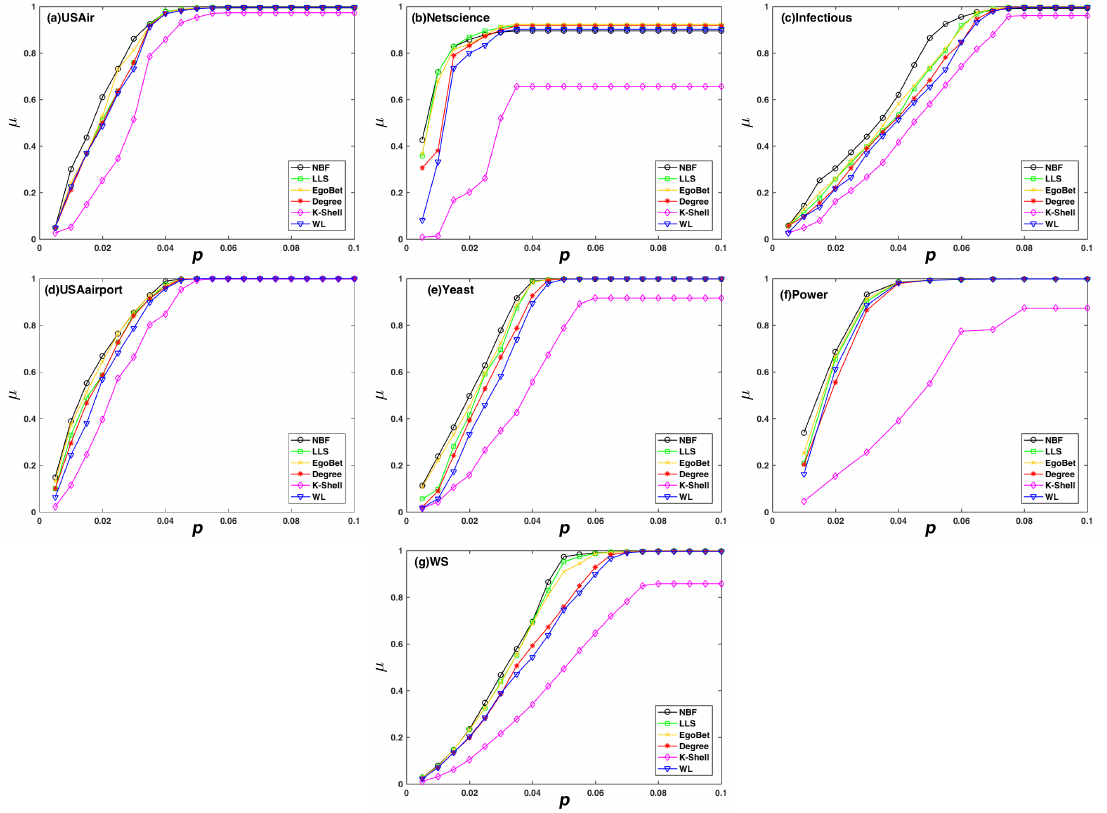
Figure 5. The decline rate of network efficiency ( µ ) subjects with different dynamic attack strategies. The decline rate of network efficiency ( µ ) on the y -axis against the rate of removed node ( p ) on the x -axis. ( a ) the USAir network; ( b ) the Netscience network; ( c ) the Infectious network; ( d ) the USAirport network; ( e ) the Yeast network; ( f ) the Power network; ( g ) the synthetic network